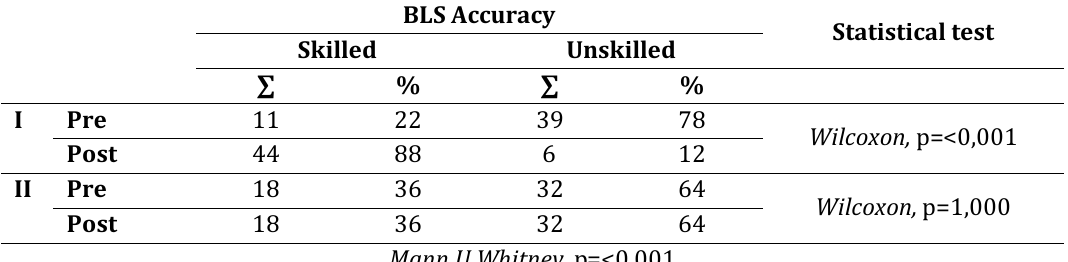
Accuracy of BLS Nurse Emergency at Public health center